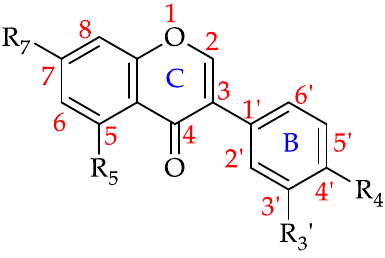
Figure 11. Basic flavan-3-ol structure (see 73 – 80 in Table 6).